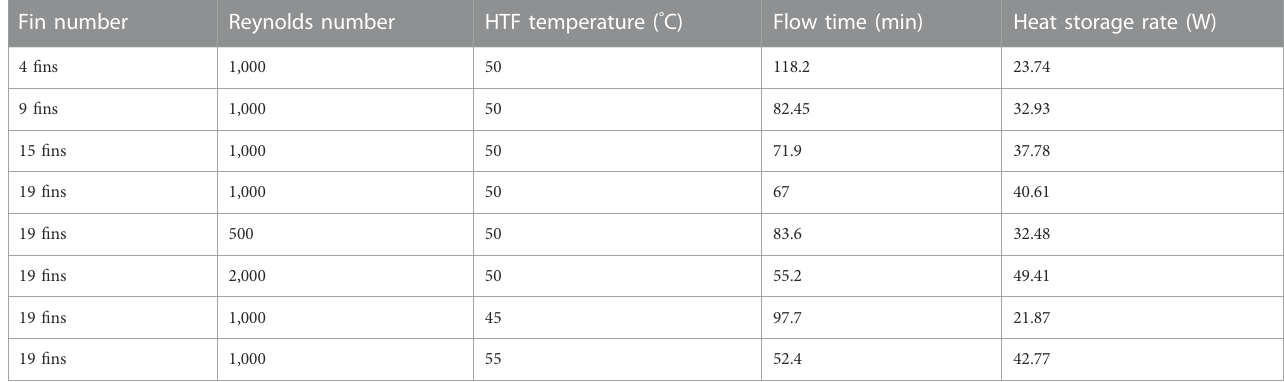
TABLE 2 Impact of fi n number, Reynolds number, and HTF temperature on the total charging time and the heat storage rate. Fin number Reynolds number HTF temperature ( ° C) Flow time (min) Heat storage rate